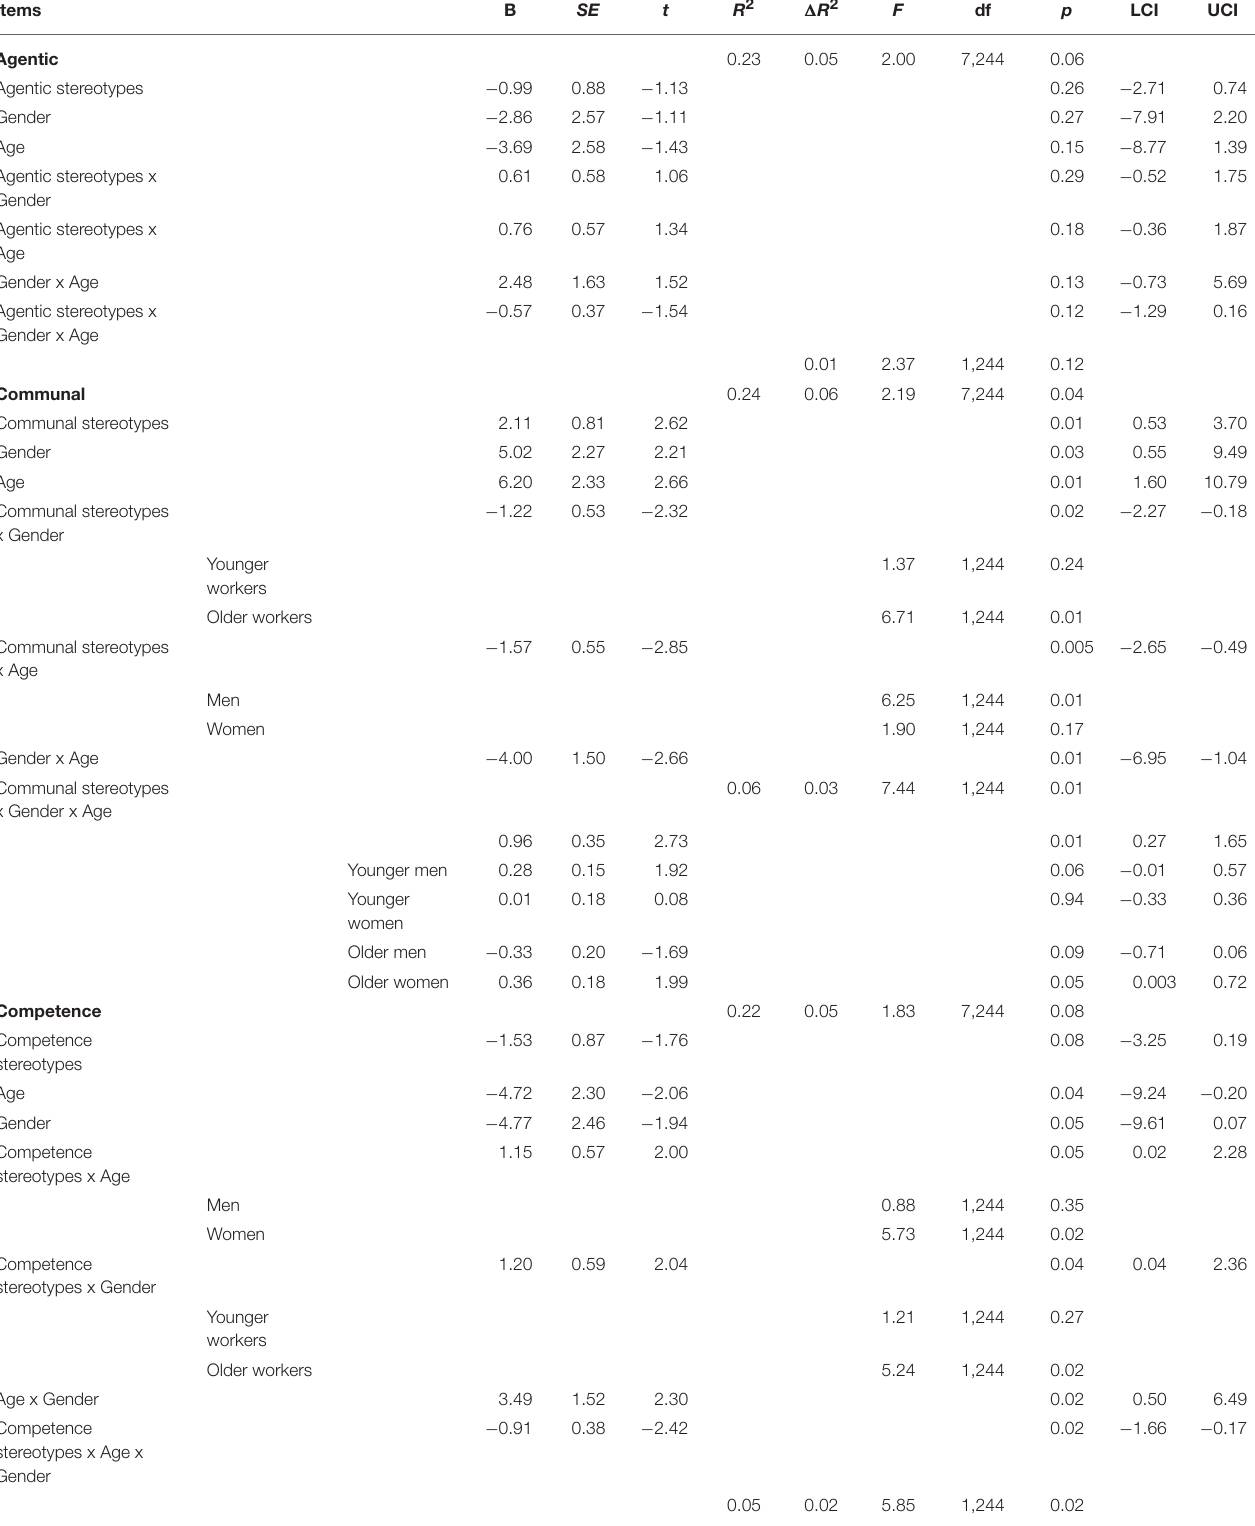
TABLE 4 | Study 1: three-way interaction between endorsement of stereotypes, participant gender and participant age on self-rated leadership potential. Items